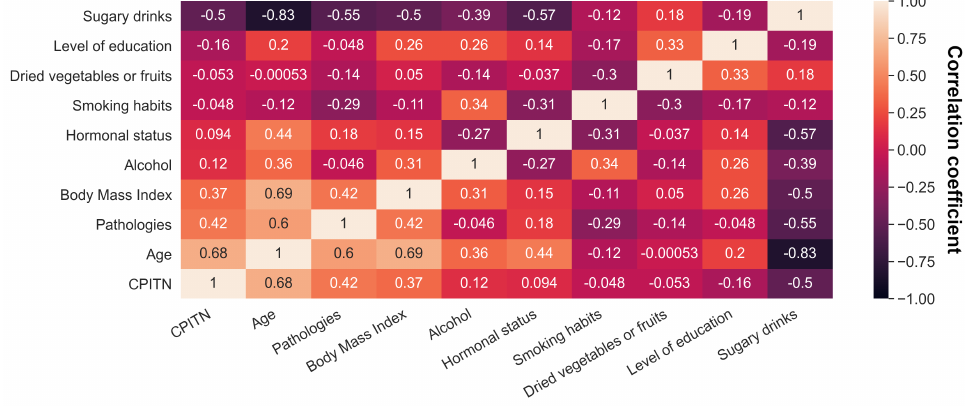
Figure 2. Variable correlation matrix. The matrix shows the Pearson correlation between CPITN and the variables selected by the BorutaPy algorithm. Age, body mass index, and the presence of a systemic disease are positively associated with CPITN, while sugary drink consumption is negatively associated with CPITN. The low association of CPITN with hormonal status can be explained as a multi–variable effect, as the hormonal status depends, among others, on both gender and